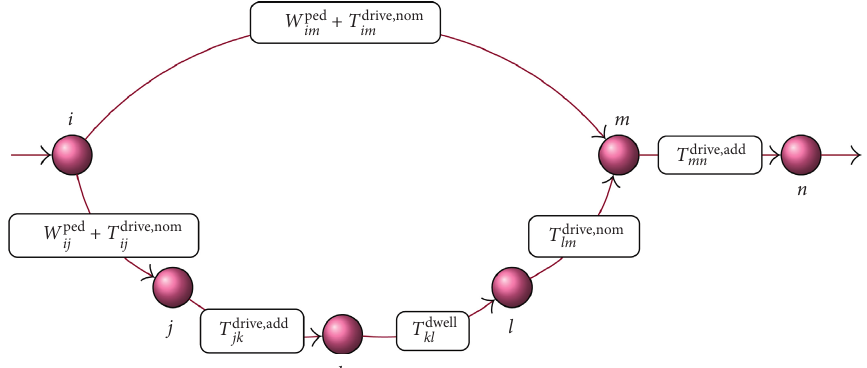
Figure 10: Network representations of the stop module. At node i and l , nominal driving activities are initiated, and at j and m , additional driving-time activities are iterated until the additional time is equal to 0. At k , a dwell-time activity is